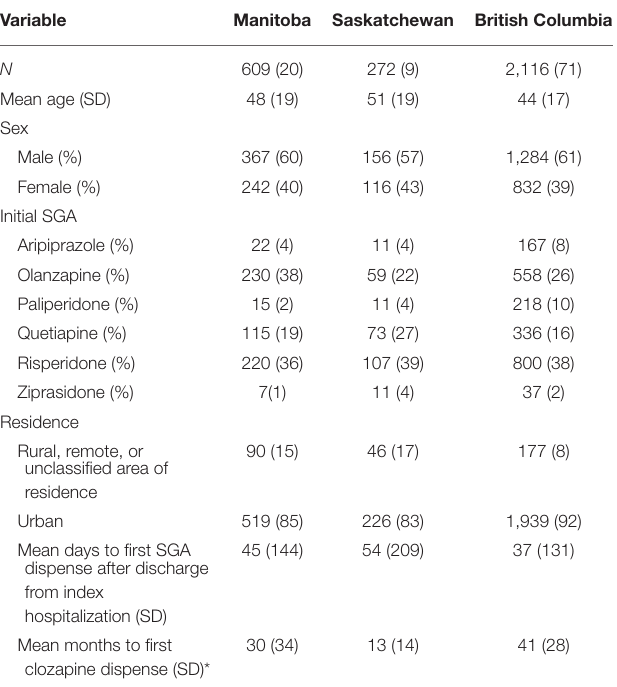
TABLE 1 | Demographic profile of schizophrenia patients at index hospitalization in three Canadian provinces. Variable